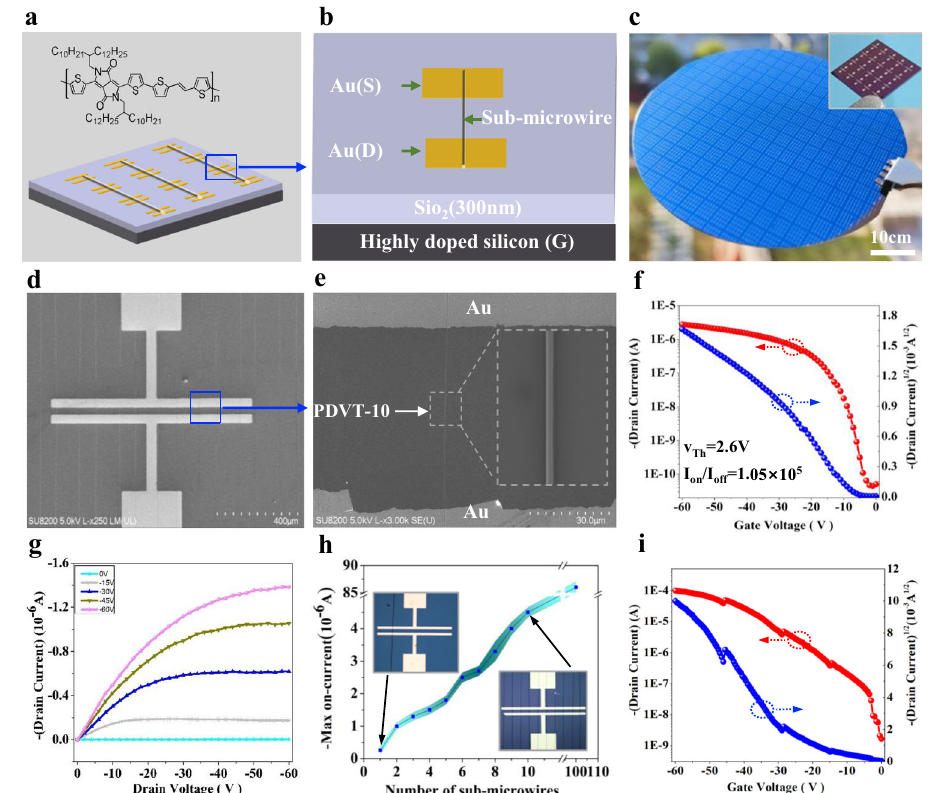
Fig.5|PerformanceanalysisofOFETs.a , b Theschematicofthesub-microwires based OFET, the sub-microwire located above the source (S) and drain (D) electrode . c Source/drain electrodes with 50 µ m channel length, the illustration in the picture shows single parallel electrode . d , e SEM images of PDVT-10 sub-microwire arrays across two electrodes. f Transfer characteristic for the